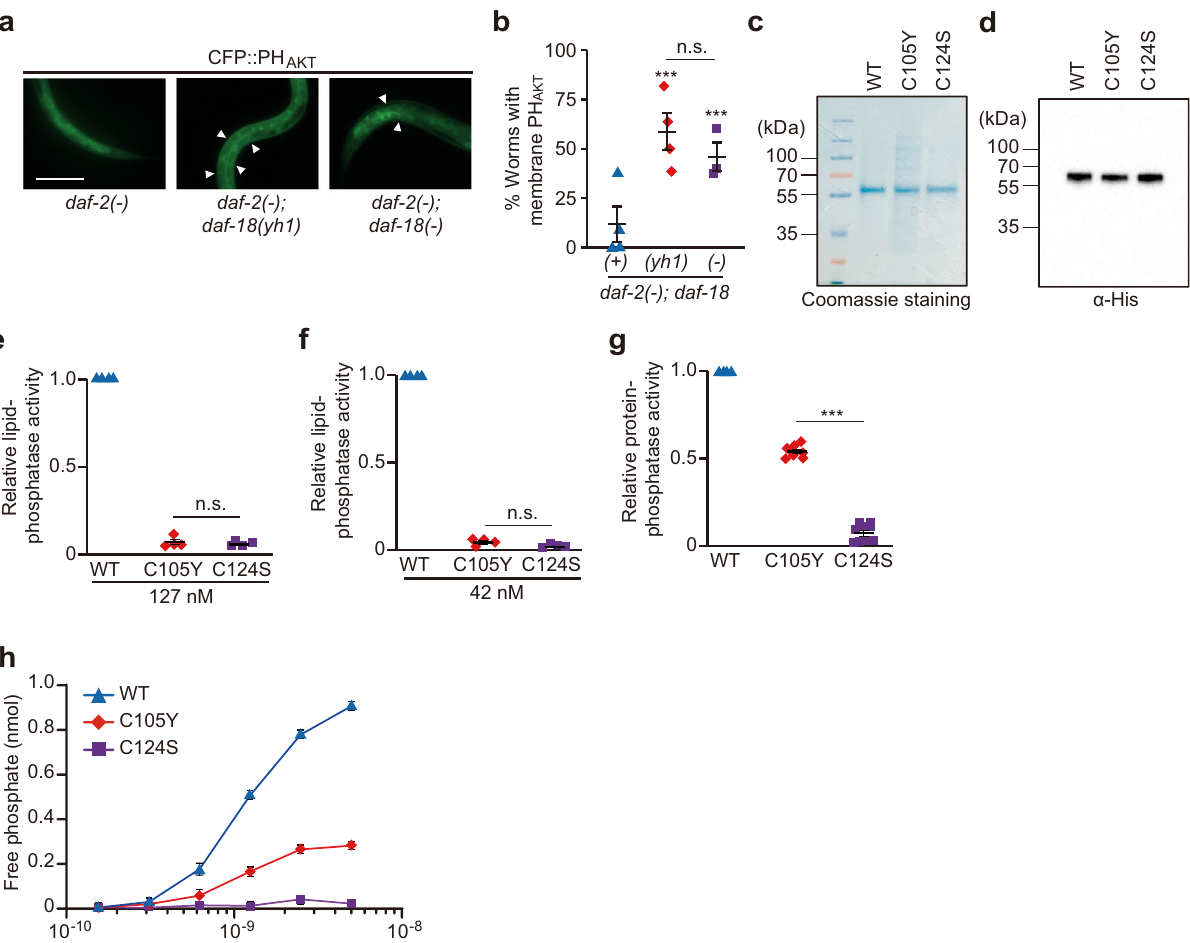
exception was a missense mutant allele, daf-18(pe407) 33 , which ally decreasing dauer formation at 25 °C (Supplementary Fig. 6b, c). Due to the small number of tested daf-18 mutant alleles, we cannot rule out different threshold levels for the suppression of daf-2( − ) mutant phenotypes. However, these data are not con- sistent with the possibility that the threshold for the suppression of constitutive dauer phenotype in daf-2( − ) mutants is lower than that of enhanced pathogen resistance. Thus, yh1 appears to